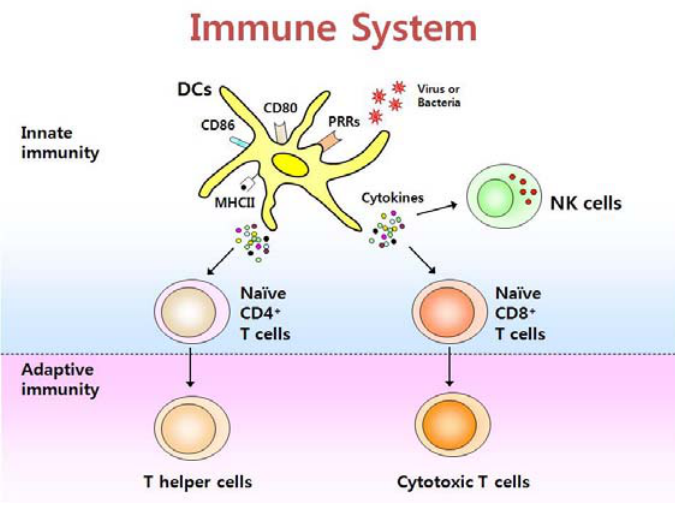
Figure 1. The immune system consists of innate and adaptive immunity. Dendritic cells (DCs) are a crucial element of the immune system, bridging innate and adaptive immunity. Upon stimulation with PAMPs, DCs secrete cytokines that activate natural killer (NK) cells and also help to differentiate CD4 + and CD8 + T